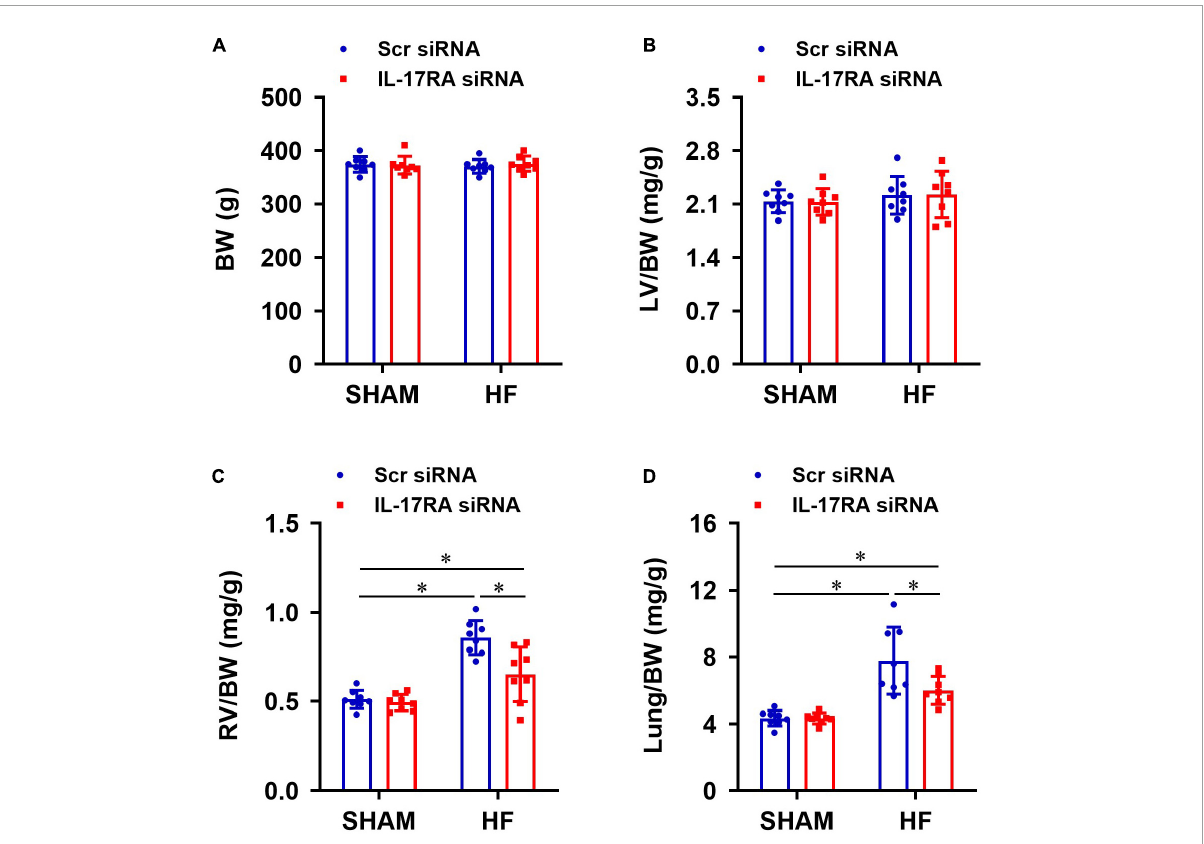
FIGURE7 Anatomic measurements including body weight (BW, A ), the ratios of left ventricular weight-to-BW (LV/BW, B ), right ventricular weight-to-BW (RV/BW, C ), and wet lung weight-to-BW (Lung/BW, D ) from each group 4 weeks after coronary artery ligation. Values are mean ± SEM ( n = 8 for each group); * p <